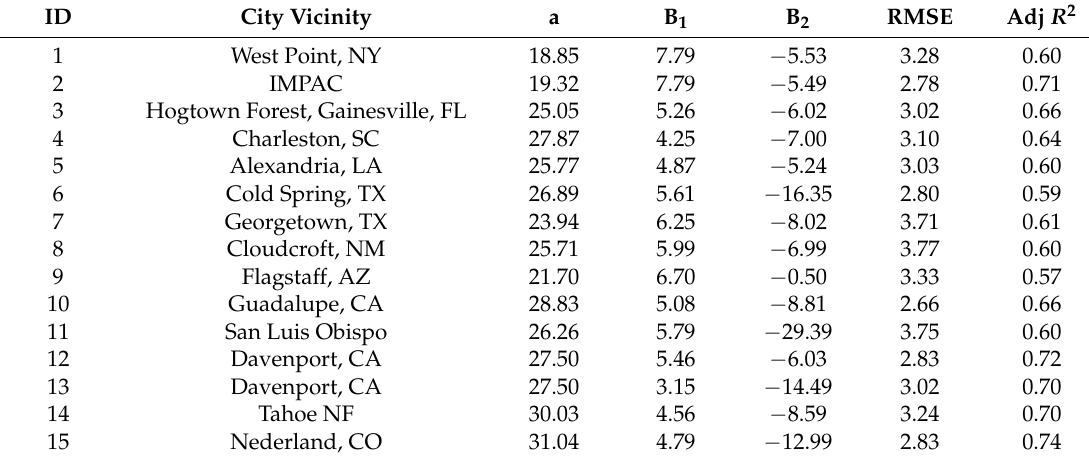
Table 2. Canopy Closure Predictive Model Results with coefficients a , B 1 , and B 2 are in reference to Equation (3) and the root Mean Square Error